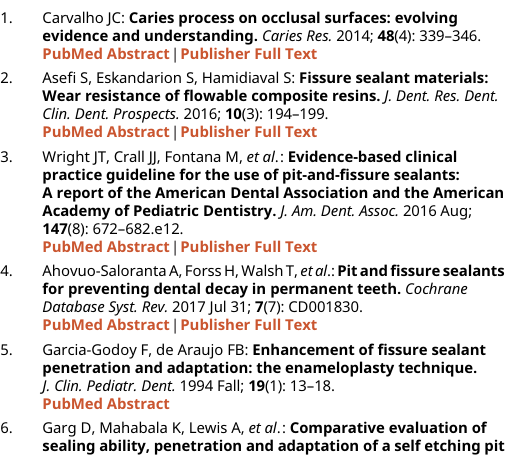
Figshare: unidentifiable Data. https://doi.org/10.6084/m9.figshare.19207596. 21